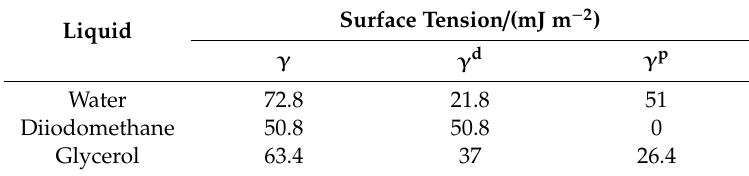
Table 1. Surface tensions ( γ ) of test liquids and their dispersive ( γ d ) and polar ( γ p ) components. Liquid Water 72.8 21.8 51 Diiodomethane 50.8 50.8 0 Glycerol 63.4 37